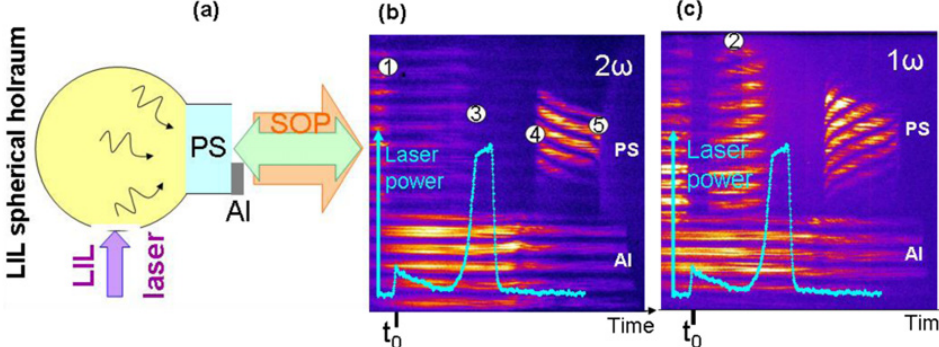
Figure 3. Shock timing experiment configuration (a); 1 (cid:2) (b) and 2 (cid:2) (c) VISAR signals.